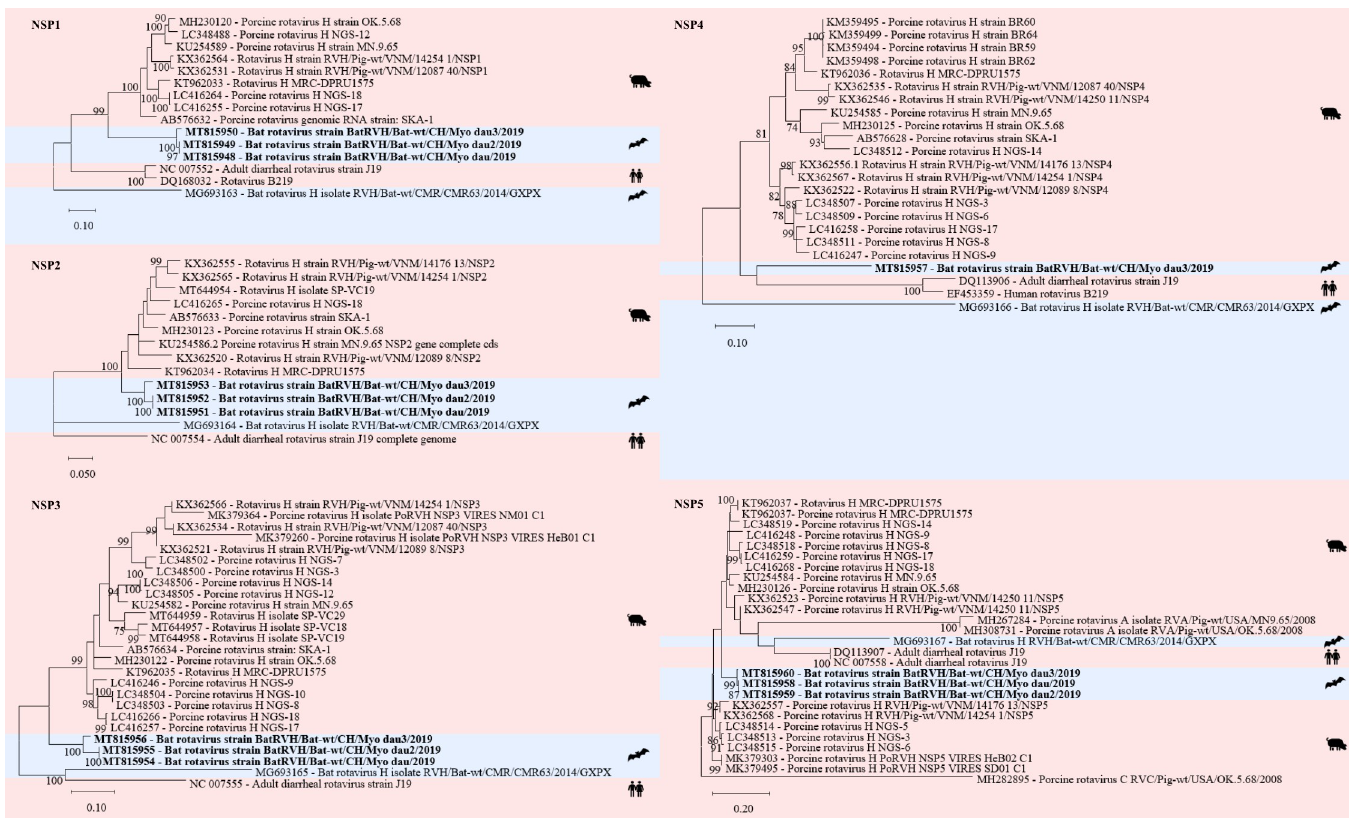
Fig 7. Phylogenetic analysis of specific regions of the rotavirus H genome. The sequences obtained in this study (GenBank acc. numbers MT815948-60) are shown in bold. Sequences of non-bat associated viruses are marked with a red background and those of bat associated viruses with a blue background. The pictograms on the right side represent the species in which the virus was detected. Sequences were aligned using Muscle. For phylogenetic analysis, the Maximum likelihood tree with 1’000 bootstraps was used. Only values � 70% are displayed.